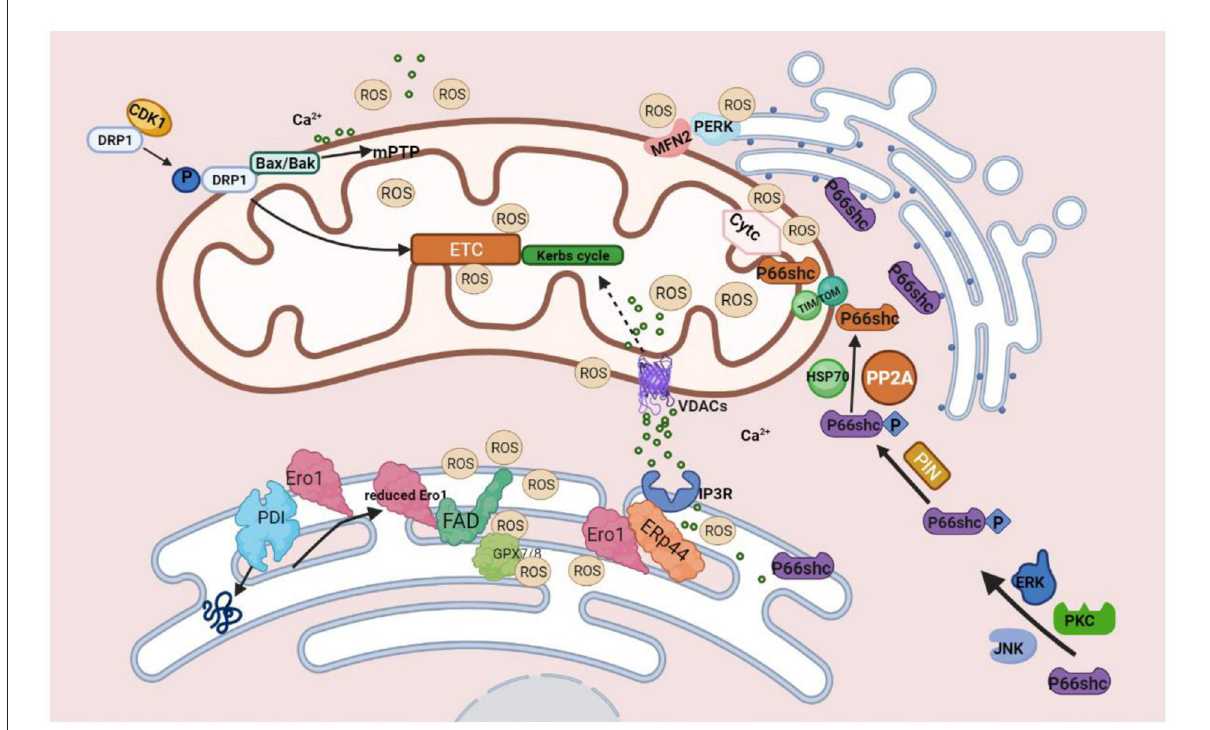
FIGURE2 Molecules on MAMs mediated ROS production. During the process of protein folding, PDI catalyzes the formation of disulfide bonds, and it is reduced in this process. The reduced PDI is then oxidized and regenerated by ERO1 and participates in the cycle of the catalytic reaction. At this time, the reduced ERO1 transfers electrons to molecules of oxygen with the assistance of the coenzyme FAD and finally releases ROS. The generation of ROS by ERO1 α does not accumulate in or leak from the ER because of GPx7, GPx8, which can eliminate excessive ROS. During ER stress, ERO1 α oxidizes IP3R1, causing the detachment of ERP44, which is found in MAMs and can bind to IP3R1 to inhibit the transfer of Ca 2 + to mitochondria from IP3R1 to promote the release of Ca 2 + from ER, ultimately leading to excessive mtROS production finally.P66SHC is phosphorylated with the assistance of ERK, JNK, and PKC kinases. Ser36 of the CH2 domain forms Ser-Pro bone under the influence of Pin1, and then P66shc is transported into the mitochondria via TOM/TIM with the assistance of dephosphatase PP2A and chaperone HSP70. P66SHC binds to oxidized cytochrome c to generate ROS. Three pathways of DRP1-mediated ROS production: 1. Under the influence of CDK1, phosphorylated DRP1 translocates to mitochondria and impairs ETC, leading to mitochondrial dysfunction and increased production of ROS. 2. Drp1 binds to BAX/BAK directly, leading to the formation of mPTP, which can produce excessive ROS. 3. Ca 2 + promotes the translocation of DRP1 and participates in mPTP formation, which eventually leads to mitochondrial dysfunction and increases ROS production. MFN2 can interact with PERK to reduce ROS